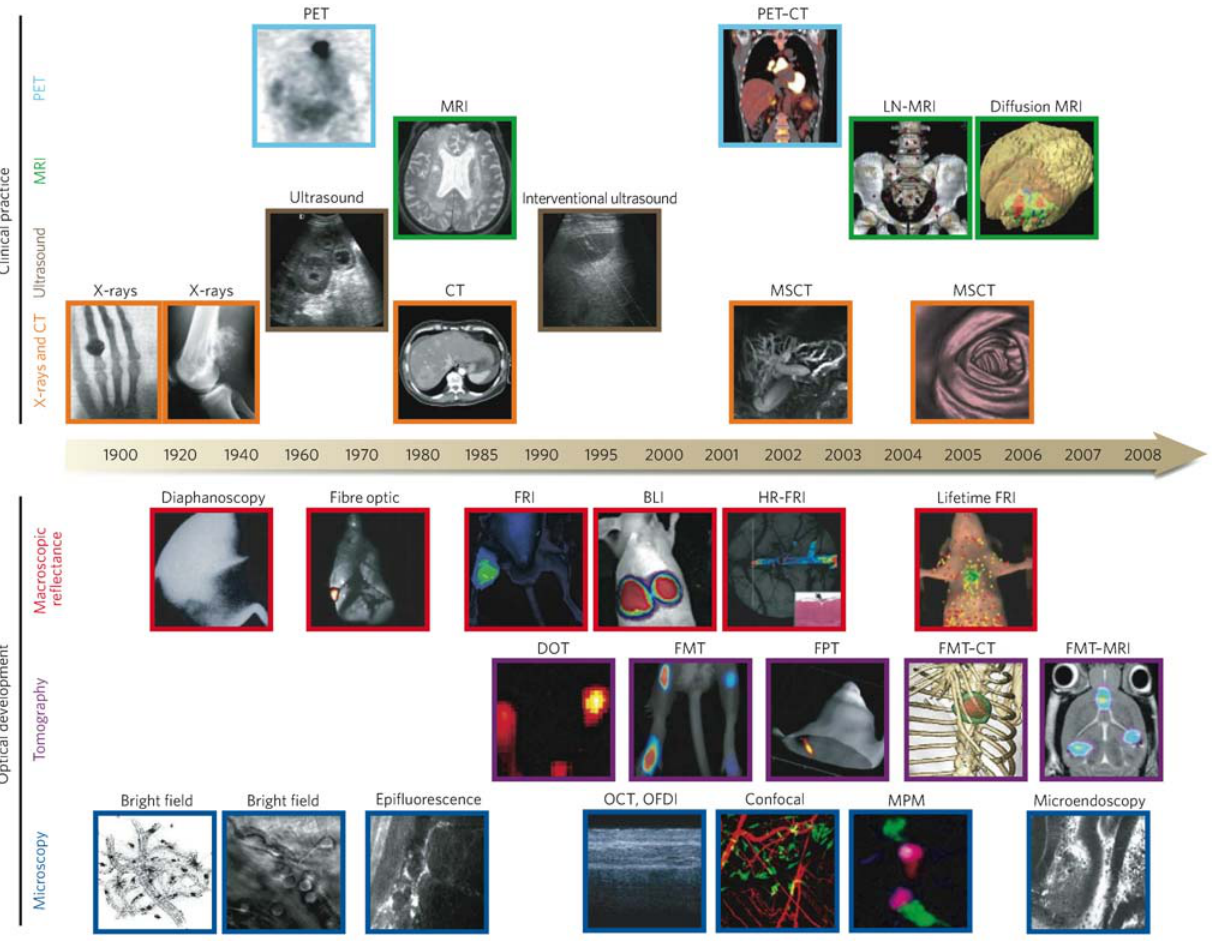
Figure 2. Imaging technologies used in oncology. Many macroscopic imaging technologies (shown above the timeline) are in routine clinical use, and there have been huge advances in their capabilities to obtain anatomical and physiological information since the beginning of the twentieth century. Shown are some examples of bones (X-rays), soft tissue (ultrasound, MRI and CT rows), three-dimensional organs (CT and MRI rows) and physiological imaging (MRI and PET rows). Microscopic and other intravital optical techniques (shown below the timeline) have developed over the past decade and now allow studies of genetic, molecular and cellular events in vivo . Shown are surface-weighted, whole-mouse, two-dimensional techniques (macroscopic reflectance row); tomographic three-dimensional techniques, often in combination with other anatomical modalities (tomography row); and intravital microscopy techniques (microscopy row). The timeline is approximate and is not to scale. Here BLI, bioluminescence imaging; CT, computed tomography; DOT, diffuse optical tomography; FMT, fluorescence-mediated tomography; FPT, fluorescence protein tomography; FRI, fluorescence reflectance imaging; HR-FRI, high-resolution FRI; LN-MRI, lymphotropic nanoparticle-enhanced MRI; MPM, multiphoton microscopy; MRI, magnetic resonance imaging; MSCT, multislice CT; OCT, optical coherence tomography; OFDI, optical frequency-domain imaging; PET, positron-emission tomography. Reprinted with permission from [9]. Copyright 2008 Nature Publishing